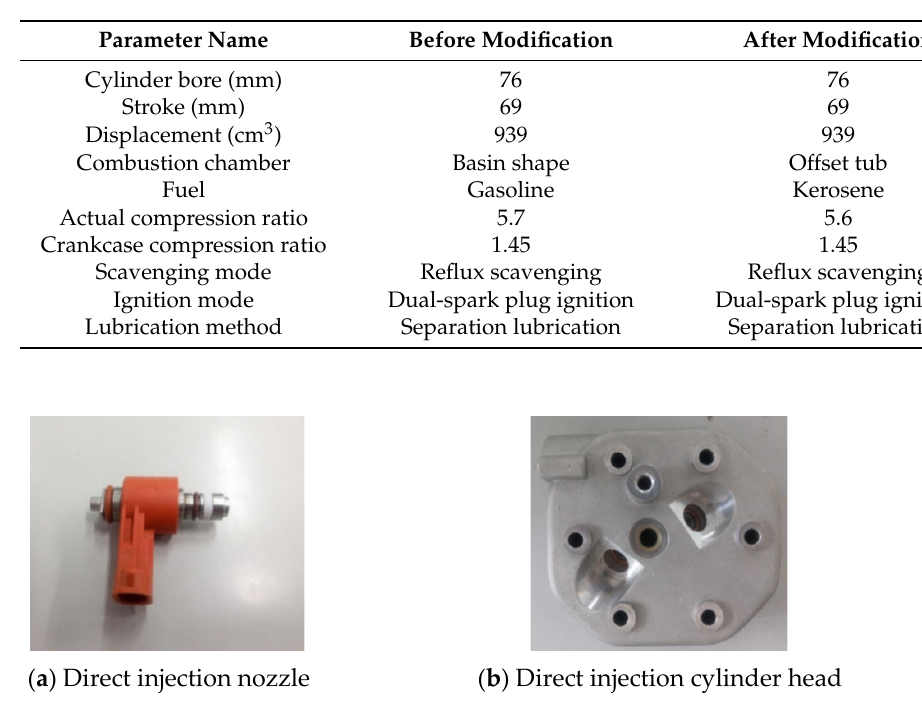
Figure 2. Photographs of the direct injection nozzle and direct injection cylinder